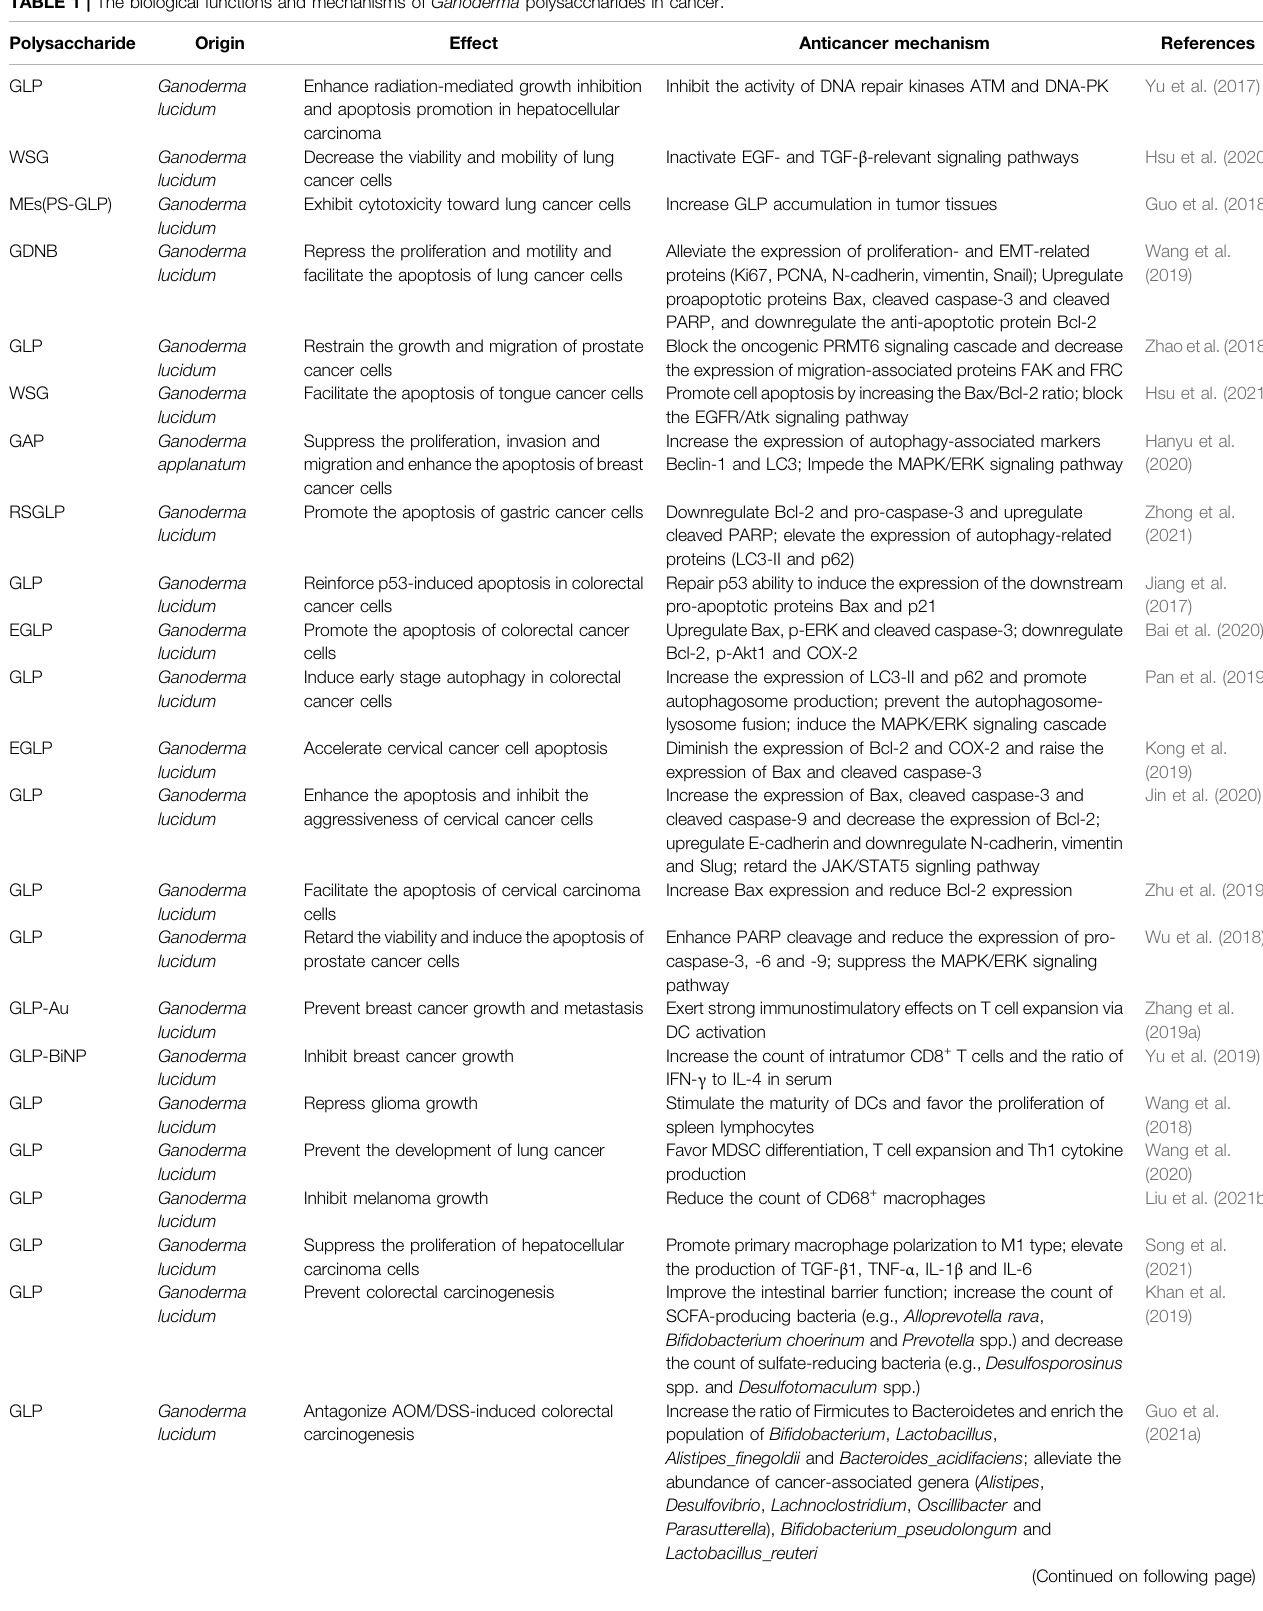
TABLE 1 | The biological functions and mechanisms of Ganoderma polysaccharides in